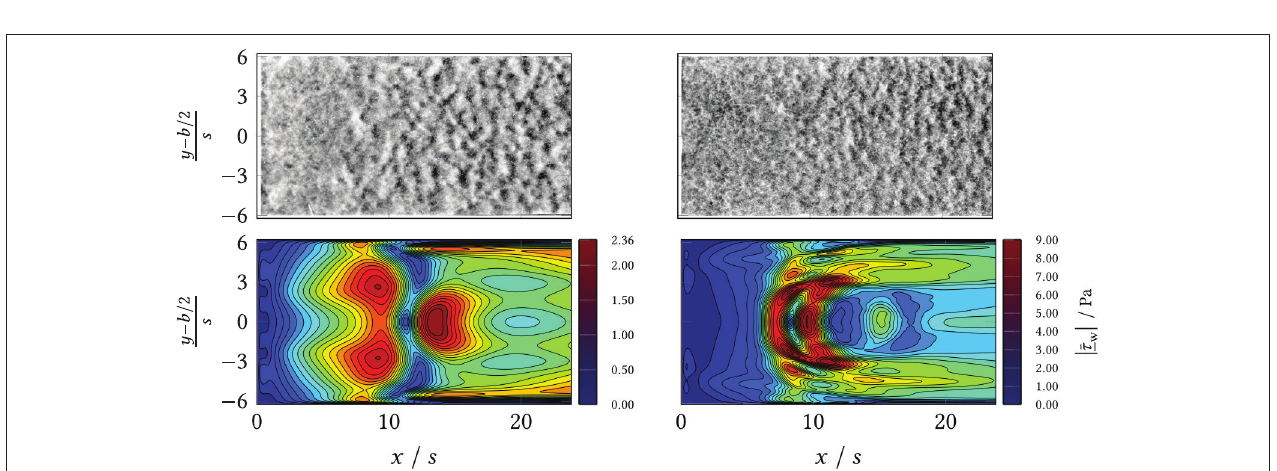
FIGURE 10 | (Top) Wide field microscopy measurements in the area behind the BFS ( x / s = 0) and separation line ( black ). (Bottom) Simulation results (CFD) of the mean shear stress magnitude. Left: volumetric flow rate ˙ V = 80 mL min − 1 ; Right: volumetric flow rate ˙ V = 120 mL min − 1 .